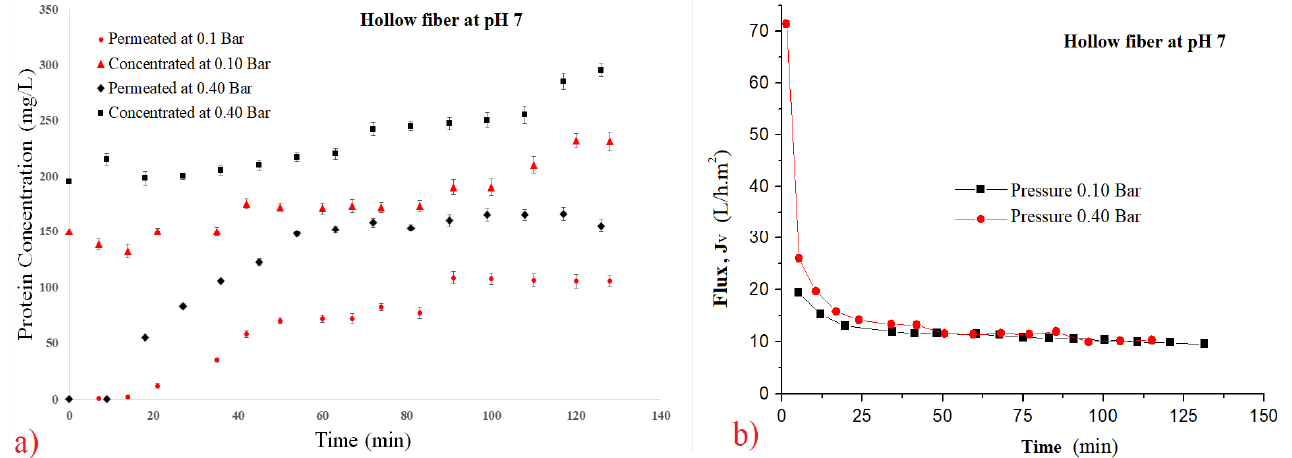
Figure 5. Effect of pressure on filtration flux of the 0.1 µm hollow fiber membrane at pH 7. ( a ) Total protein curves and ( b ) flux curves.